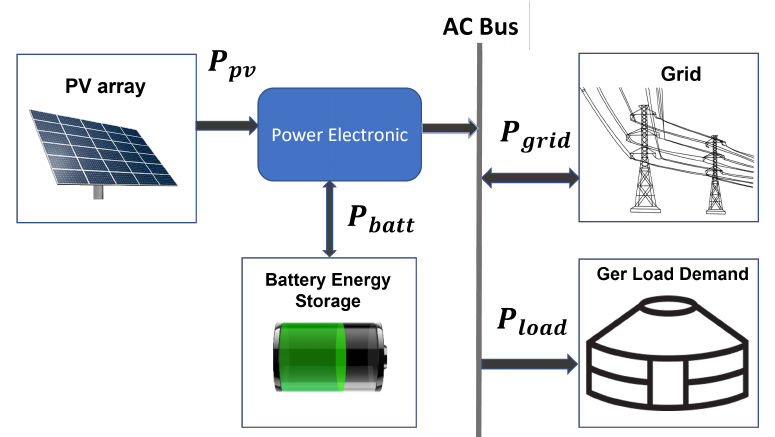
Figure 1. Layout of the grid-connected PV–SLB system.